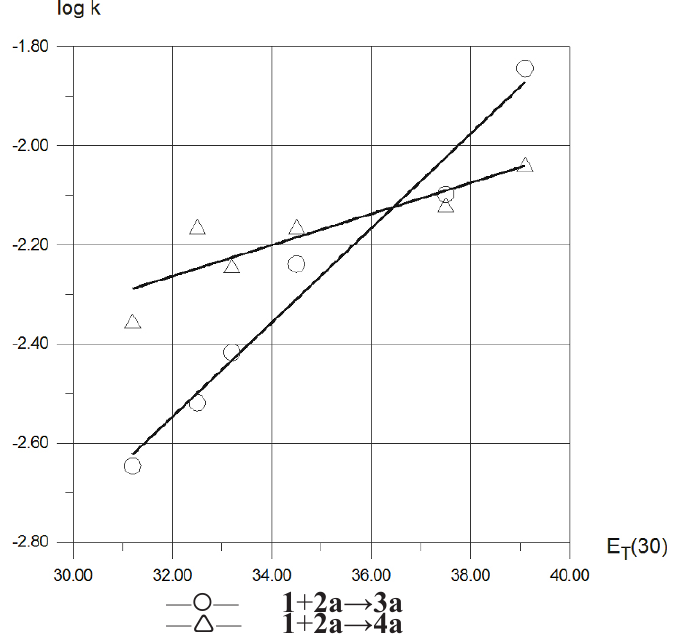
Figure 4. Plot of log k vs Dimroth E (30) constants for [2+3] cycloaddition between 1-chloro-1-nitroethene 1 and (Z)-C-(p-methoxyphenyl)-N- T phenylnitrone 2a